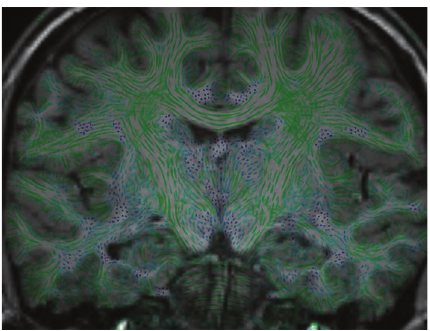
Figure 9: Fused directionally encoded LIC map and T1 slice